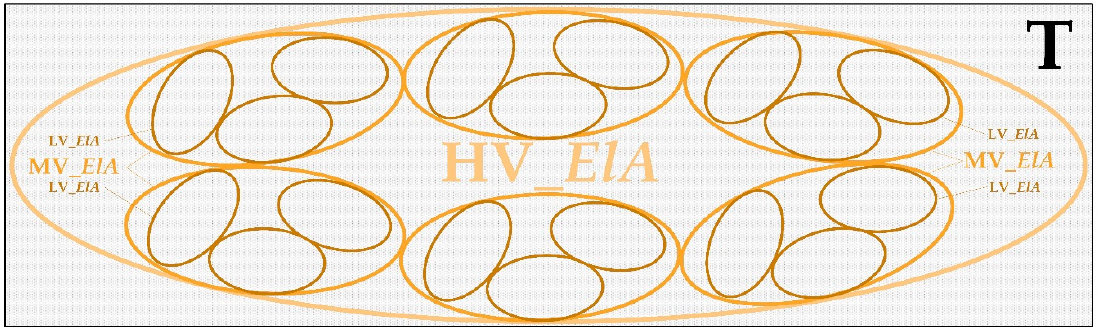
Figure 6. The fractal set of HV, MV and low voltage graphs (LVGs).